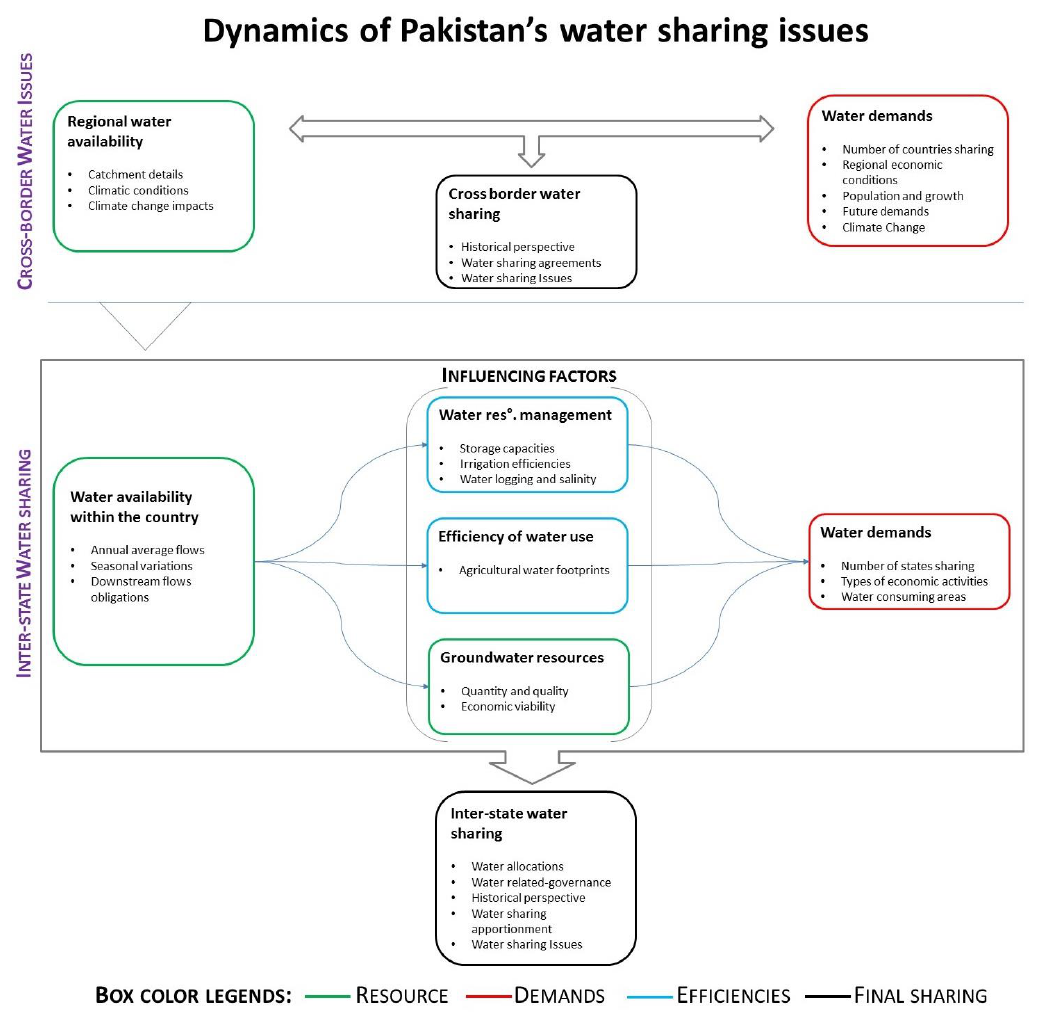
Figure 1. Schematic approach for assessment of Pakistan’s water-sharing issues.